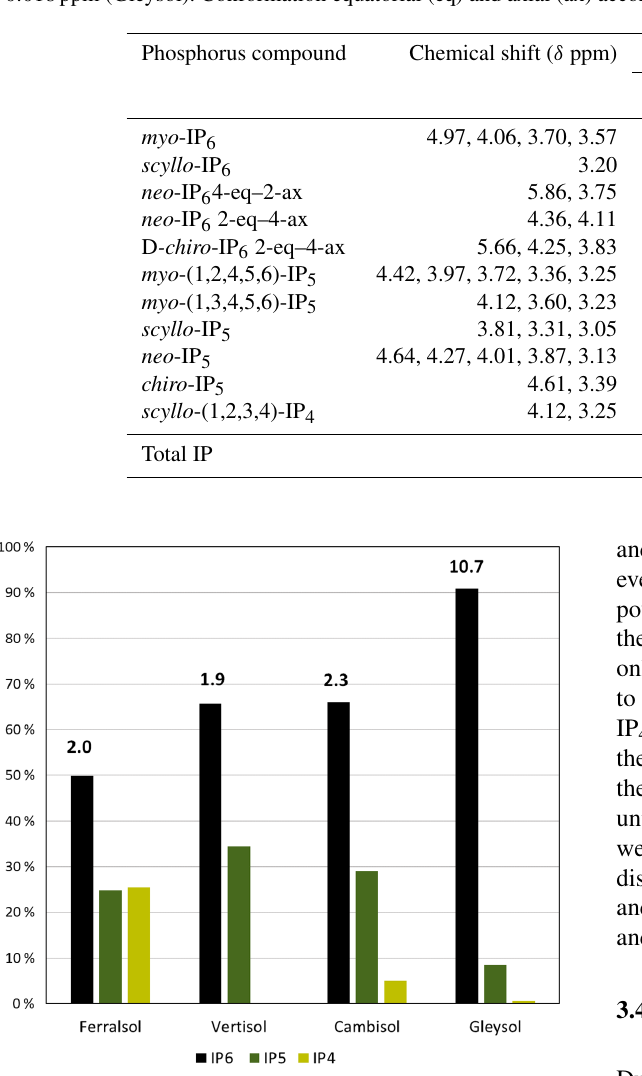
Table 5. Concentrations of identified inositol phosphates (IPs) in hypobromite oxidised 0.25MNaOH + 0.05M EDTA soil extracts (Ferral- sol, Vertisol, Cambisol and Gleysol). Concentrations were calculated from solution 31 P NMR spectra using spectral-deconvolution fitting including an underlying broad signal. When no concentration is given, the IP compound was not detected in the respective soil extract. Chemical-shift positions are based on the NMR spectrum of the Cambisol extract (Fig. S8 in the Supplement). Peak positions varied by up to + 0 . 018ppm (Gleysol). Conformation equatorial (eq) and axial (ax) according to Turner et al. (2012).